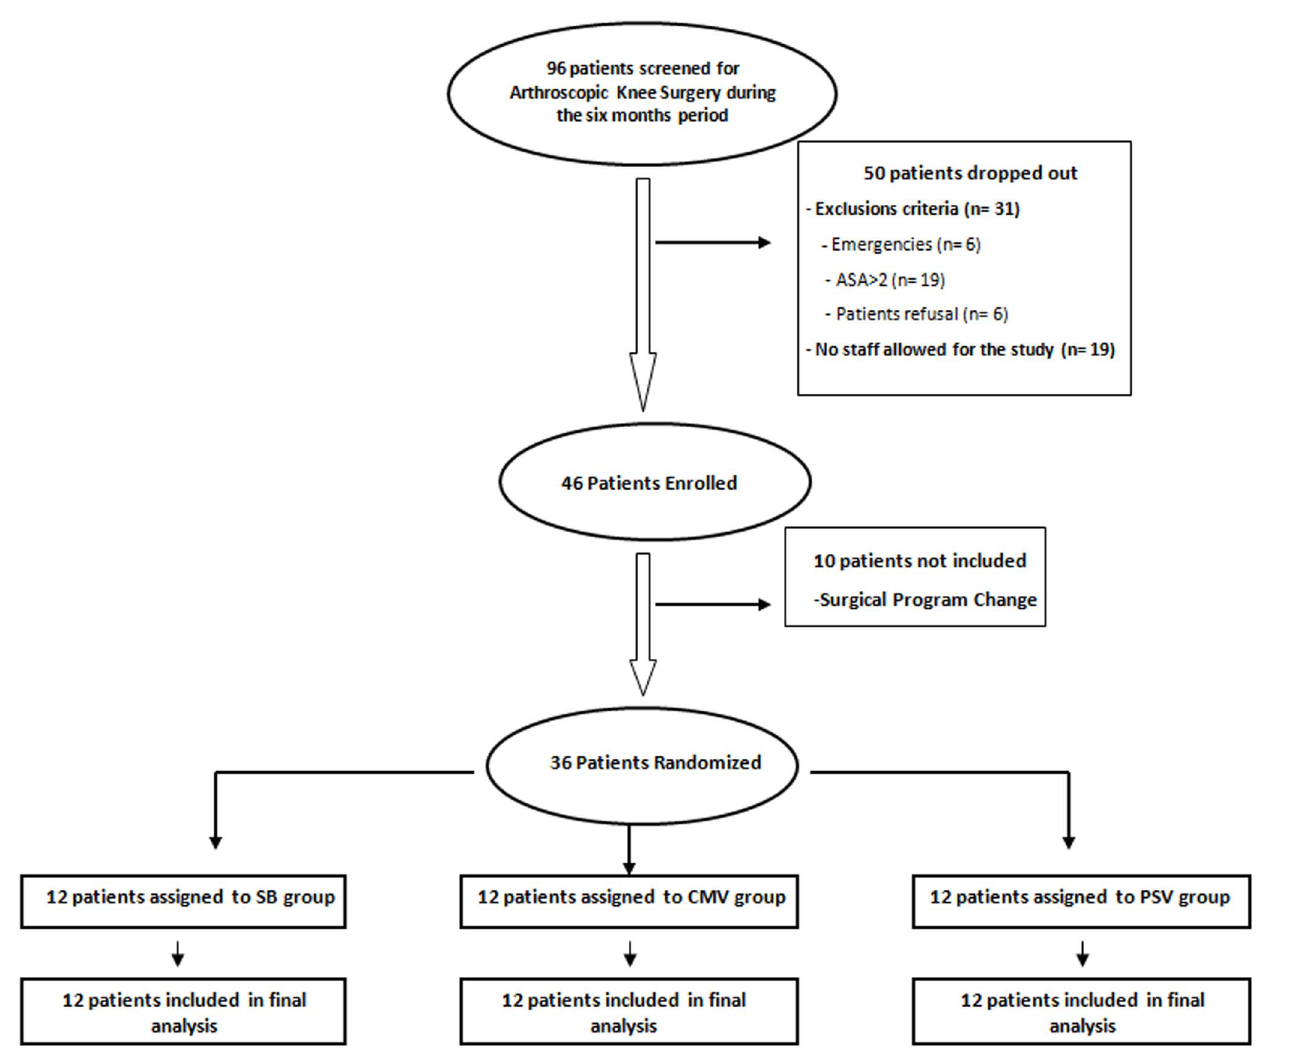
Fig. 2. Completed CONSORT flowchart of the study.